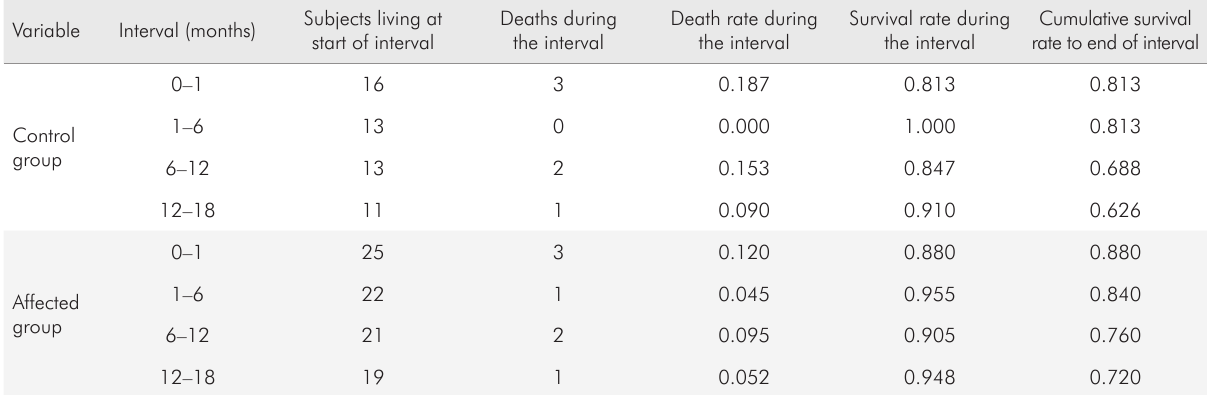
Table 3. Actuarial method for survival analysis of CG (control group) and HG (affected group) at 1, 6, 12 and 18 months of follow-up. Variable